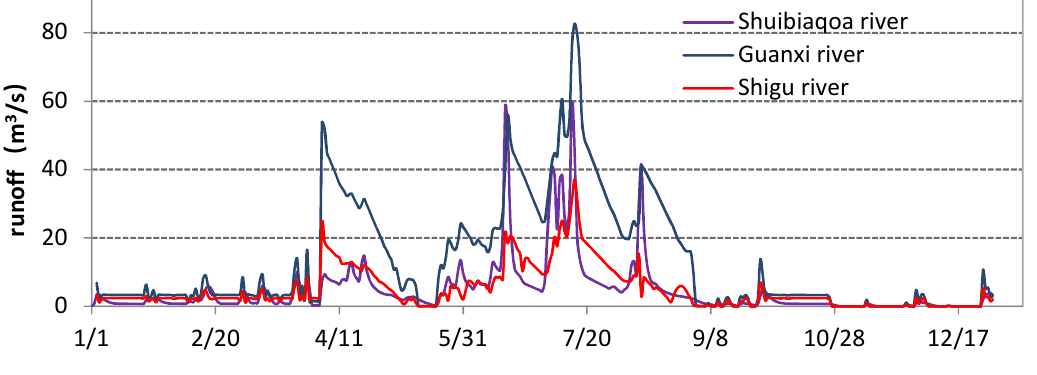
Figure 7. Runoff variation of river channels in a wet year (5%).